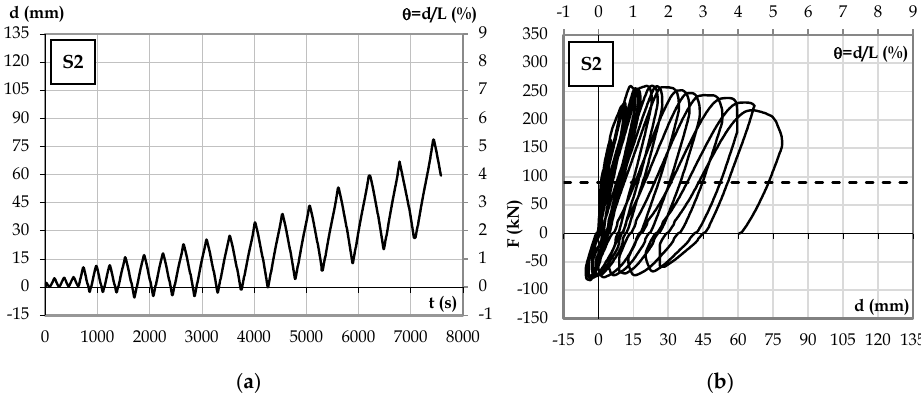
Figure 9. Specimen S2: ( a ) displacement history; ( b ) force-displacement hysteretic diagram. The displacement history and force-displacement diagram of Specimen S3, presented in Figure 10, show a maximum load of 293.00 kN and a 5.0% beam rotation. The load- displacement hysteretic diagram shows that the post-tensioning system led to less residual deformation and a higher strength capacity. The UFRG jacketing led to a more stable response with less damage. The strengthened beams presented an improvement towards a more balanced behaviour. The strands’ post-tensioning force level follows the increasing amplitude of the im- posed cyclical displacement. Figure 11 shows that the post-tensioning force increases through the test. This phenomenon may be associated with residual deformations. The disturbances close to failure, observed in the diagrams, are associated with post-tensioning losses due to beam degradation near